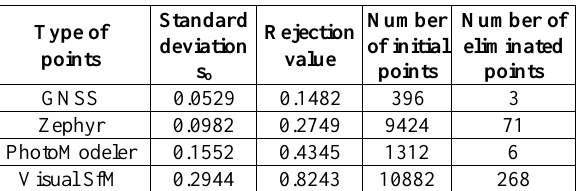
Table 5. The summary of the hyperbolic paraboloid fitting using the least squares